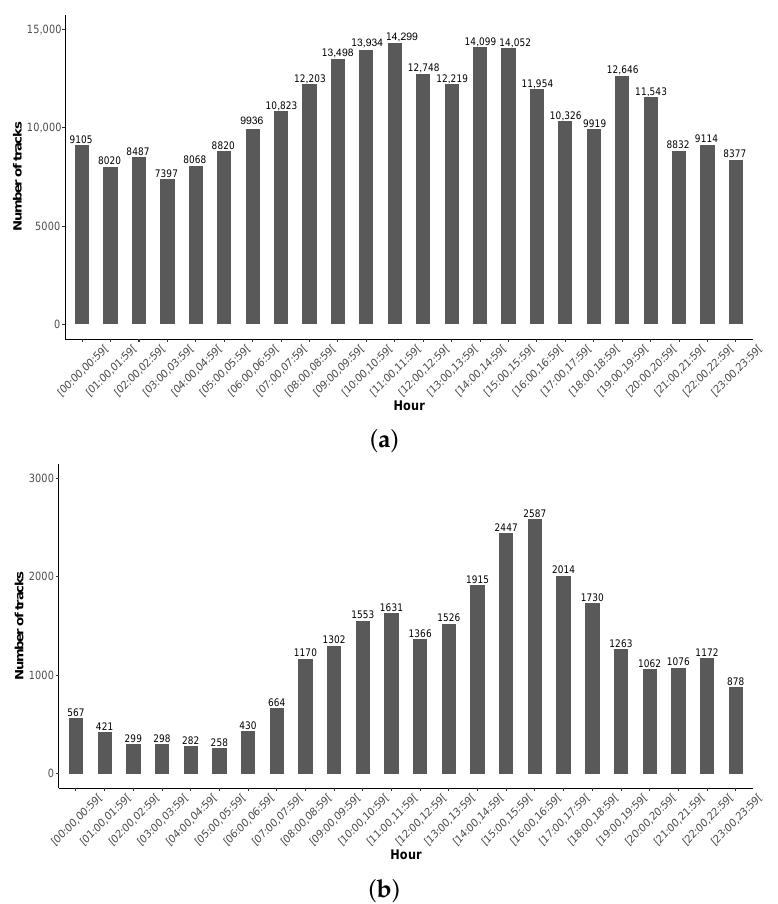
Figure 9. Distribution of tracks per hour of the day, for the entire database and for the data collected in France only. ( a ) Distribution of tracks per hour of the day, for the whole database. ( b ) Distribution of tracks per hour of the day for data collected in France only.